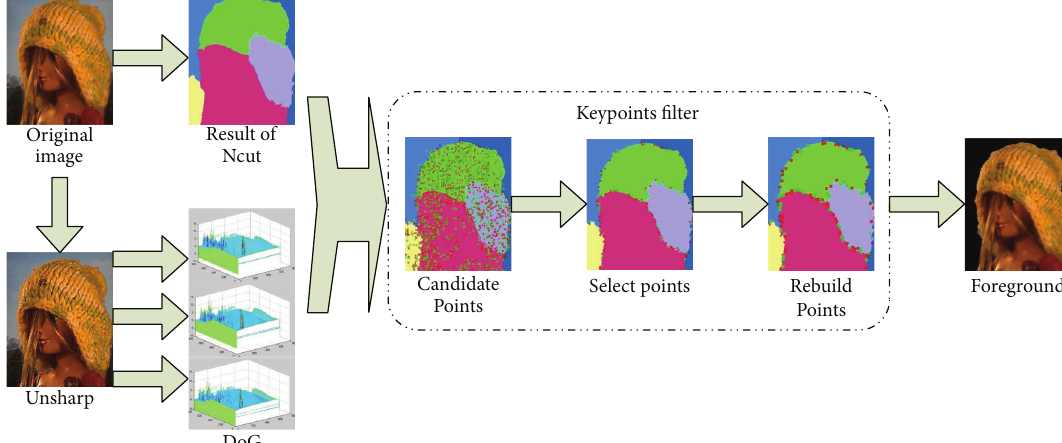
Figure 1: Flowchart of the basic procedure of FMDOG. The result of difference of Gaussian (DoG) and Normalized cut (Ncut) is combined by the keypoints filter. The last image is the foreground we extract in this model